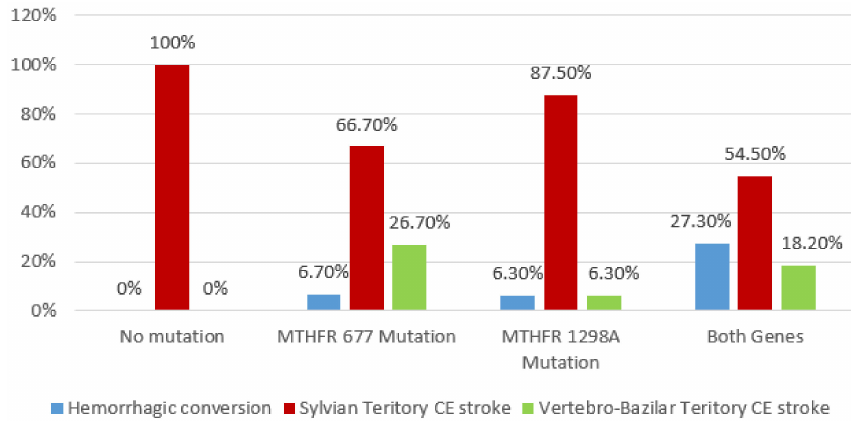
Figure 6. Association between cardioembolic stroke localization and MTHFR polymorphism by applying Chi 2 Test.